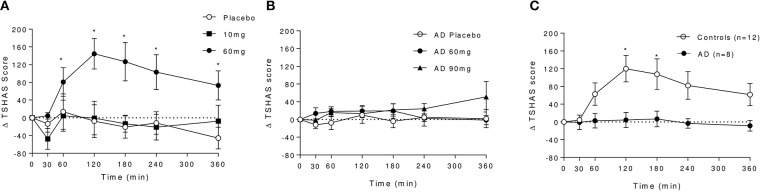
Effect of baclofen on Total SHAS (TSHAS) scores in controls and AD following placebo, 10, 60, or 90 mg baclofen. Data are mean ± S.E.M., expressed as change from baseline. (A) Effect of placebo, 10 and 60 mg baclofen on TSHAS in controls. Repeated measures ANOVA; Dose × Time Interaction: F(12, 96) = 3.20, P = 0.0007. *60 mg > placebo (P < 0.05, Tukey's multiple comparison test). (B) Effect of placebo, 60 and 90 mg baclofen on TSHAS in AD. Repeated measures ANOVA; no significant effect of dose or time, significant dose by time interaction [F(12, 60) = 2.37, P = 0.014], *90 mg > placebo (P < 0.05, Tukey's multiple comparison test). (C) Comparison of the effect of 60 mg baclofen on TSHAS in controls and AD. Mixed ANOVA; significant group effect: F(1, 18) = 6.0, P = 0.025). *60 mg > placebo (P < 0.05, Sidak's multiple comparison test).